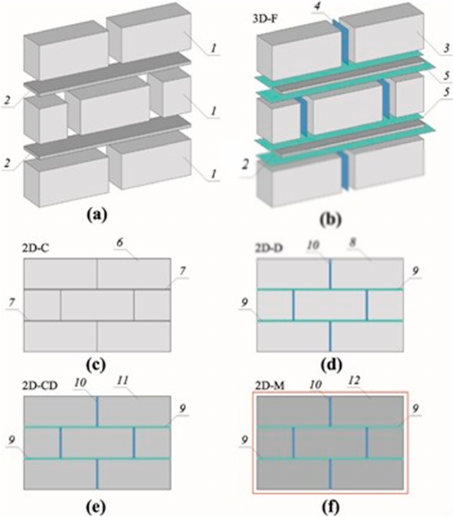
Figure 1. Adopting various strategies for developing the micro-model of the wall with thin-layer joints with unfilled head joints on the basis of [32–34,41,42]: ( a ) real structure of modelled masonry, ( b ) spatial micro-model of the wall (3D-F), ( c ) two-dimensional micro-model of the wall (2D-C), ( d ) two-dimensional micro-model of the wall (2D-D), ( e ) two-dimensional micro-model of the wall (2D- CD), ( f ) two-dimensional micro-model of the wall (2D-M) with masonry units having the equivalent non-linear parameters of the masonry; 1 —masonry unit, 2 —mortar in bed joints, 3 —masonry unit of linear or non-linear parameters, 4 – contact element of perpend joints, 5 —mortar in bed joints of linear or non-linear parameter, 6 —masonry unit of linear or non-linear parameters, 7—mortar in bed joints of linear or non-linear parameters, 8—masonry unit of linear parameters, 9—contact element of bed joints of non-linear parameters, 10—contact element of bed joints of non-linear parameters, 11— masonry unit of non-linear parameters 12—masonry unit of equivalent non-linear parameters of the wall.